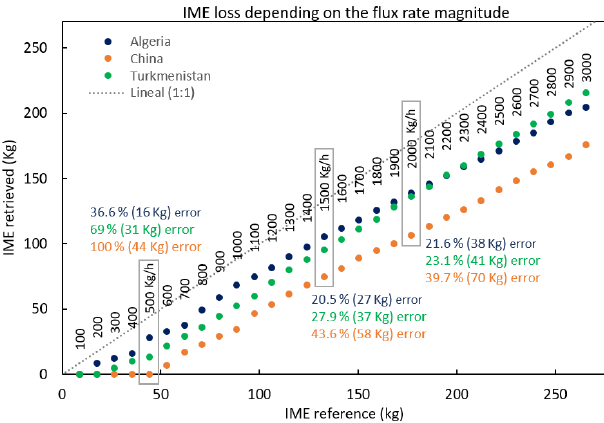
Figure 9. Test of methane detection limits. The scatter plot relates the different referenced IME values – according to each input flux rate Q labeled above the dots – and the reconstructed IME from the retrieved (cid:49) XCH 4 maps of Algeria (blue dots), Turkmenistan (green dots), and China (orange dots) sites. For Q 500kgh − 1 , Q 1500kgh − 1 , and Q 2000kgh − 1 , the IME losses are labeled in col- ors for each site showing the % of error set in the IME reconstruc- tion, and the total underestimated magnitude of the plume in kg. The black line represents the 1:1